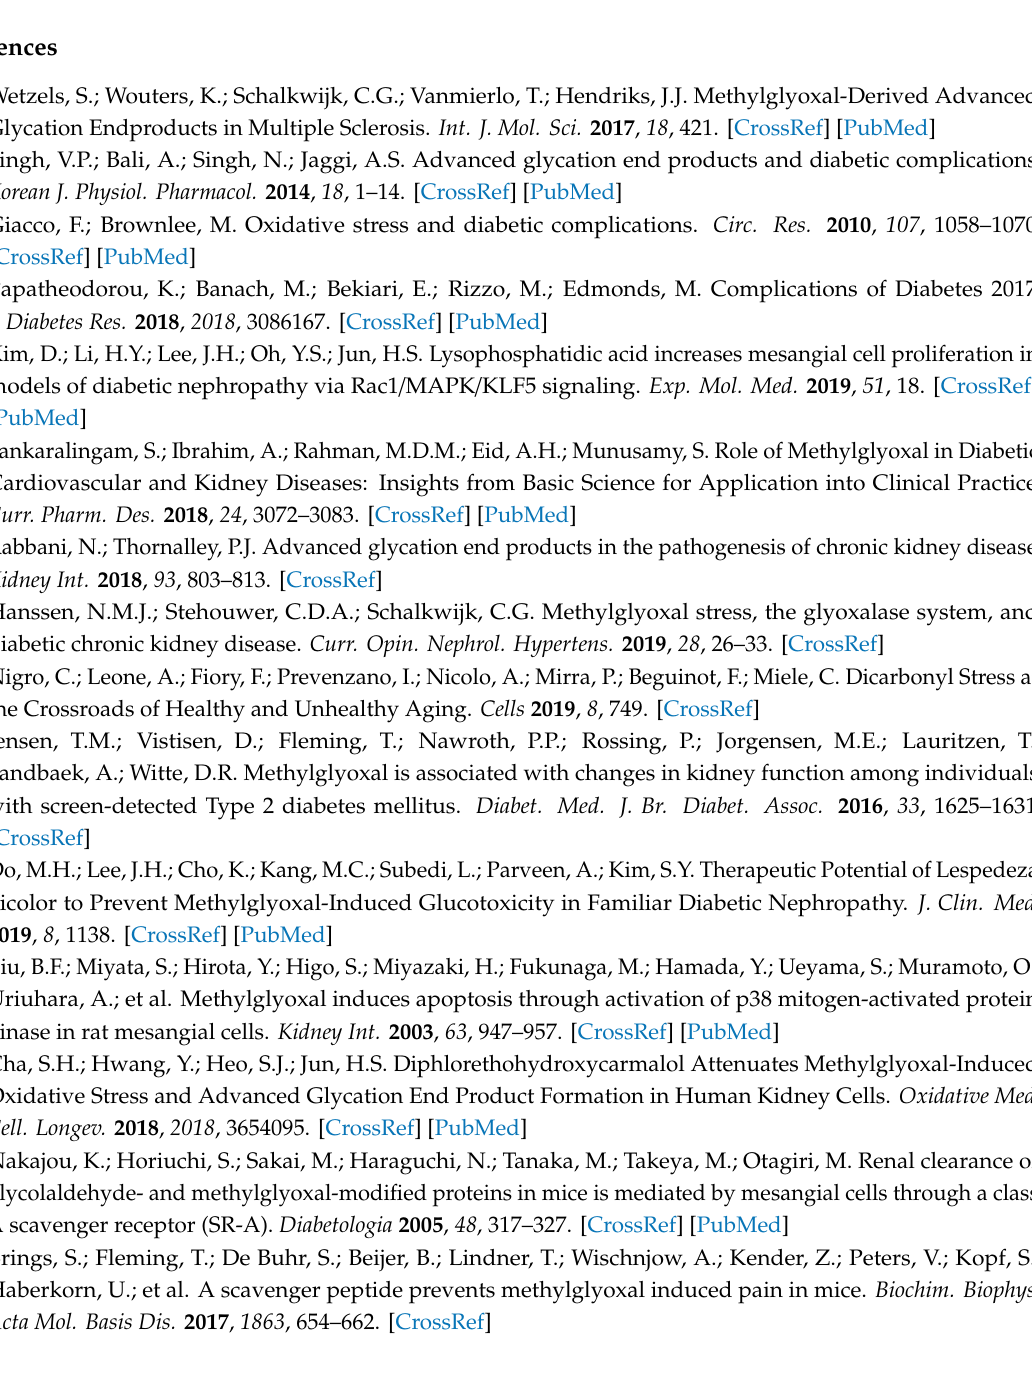
Figure S1: E ff ects of NAC and cystine on MGO-induced cell toxicity in MES13, Figure S2: E ff ects of NAC and cystine on the AGE formation and